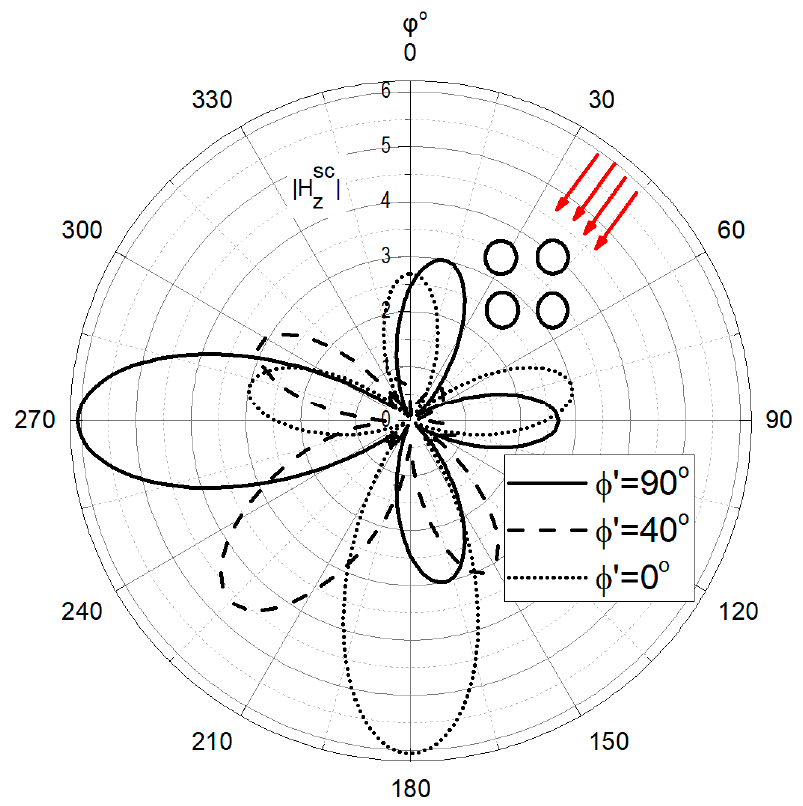
= ϕ for the inset structure, arising from that of √ 2 λ 0 , ε 1 = ε 2 = ε 4 = ε 6 = ε 8 = ε 0 , = µ σ i = 0 ( i = 1,2,3,4,5,6,7,8, 9 ) , i 0 and